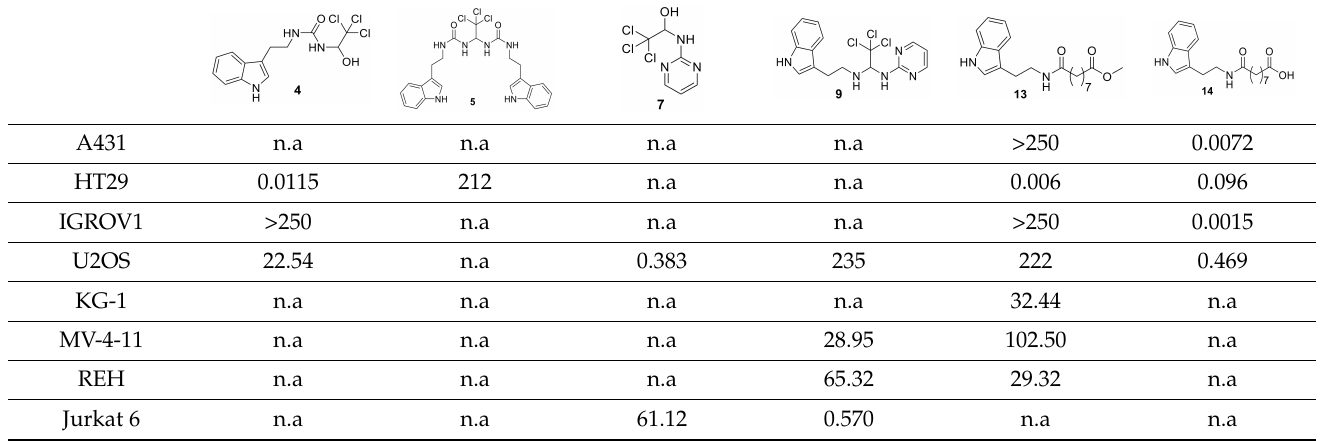
Table 1. IC 50 ( µ M) values of the new compounds in the analyzed tumor cell lines a